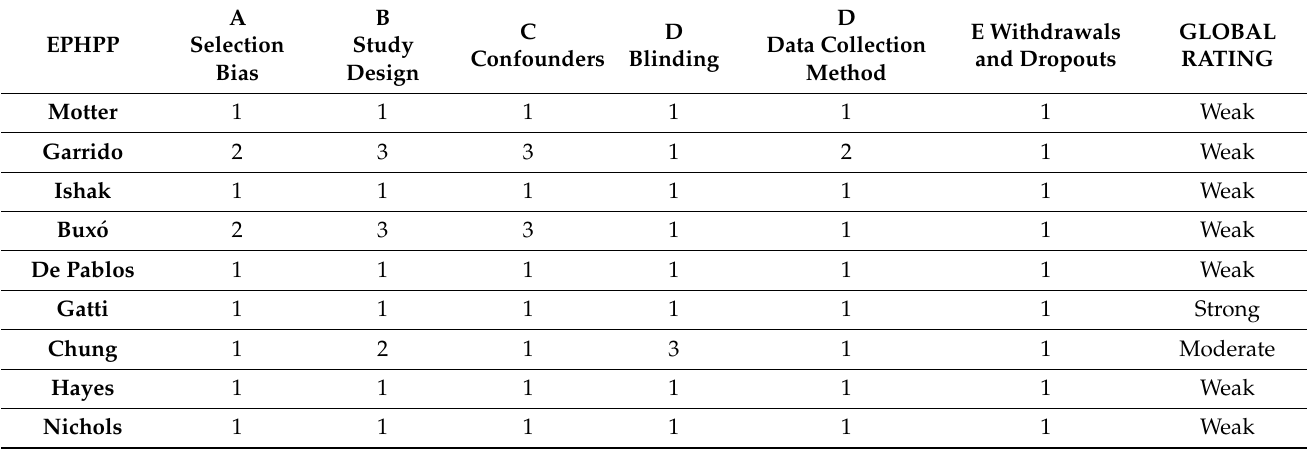
Table 2. EPHPP scale. Quality Assessment tool for quantitative